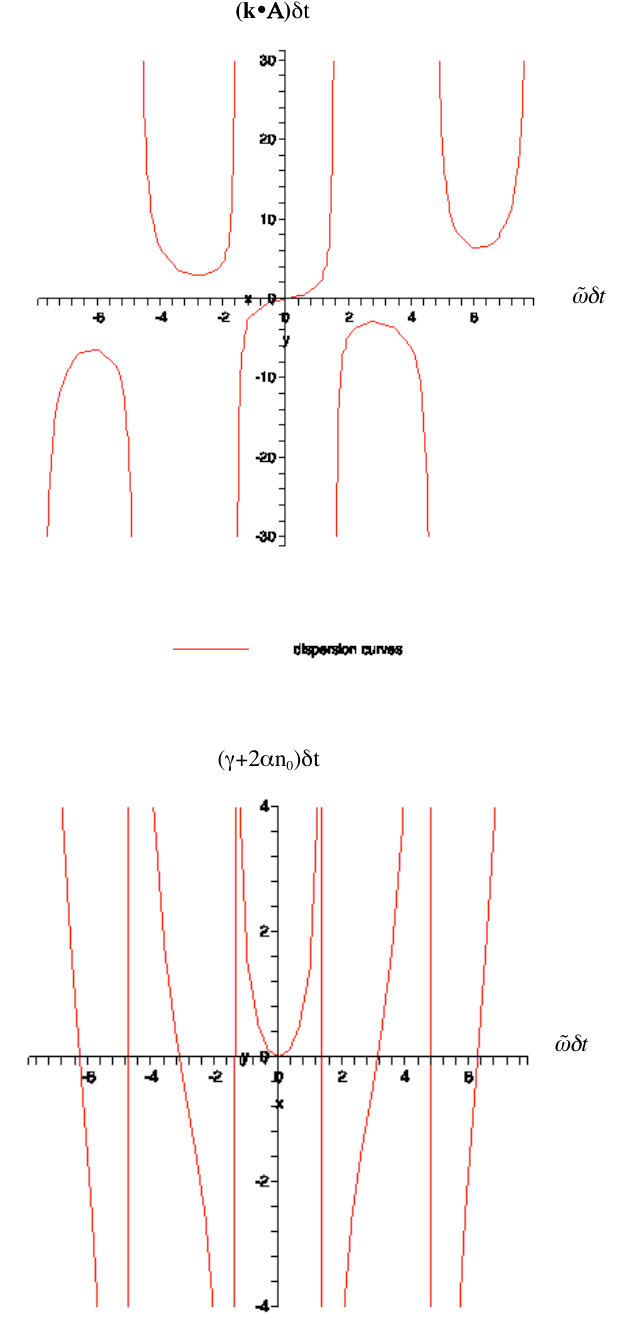
Fig. 2. The solution of the dispersion equation. Upper panel shows the dependence of the k vector versus ˜ ωδt , where ˜ ω is the frequency in the coordinate system moving at the E × B drift velocity. The lower panel shows the dependence of the growth rate γ versus ˜ ωδt